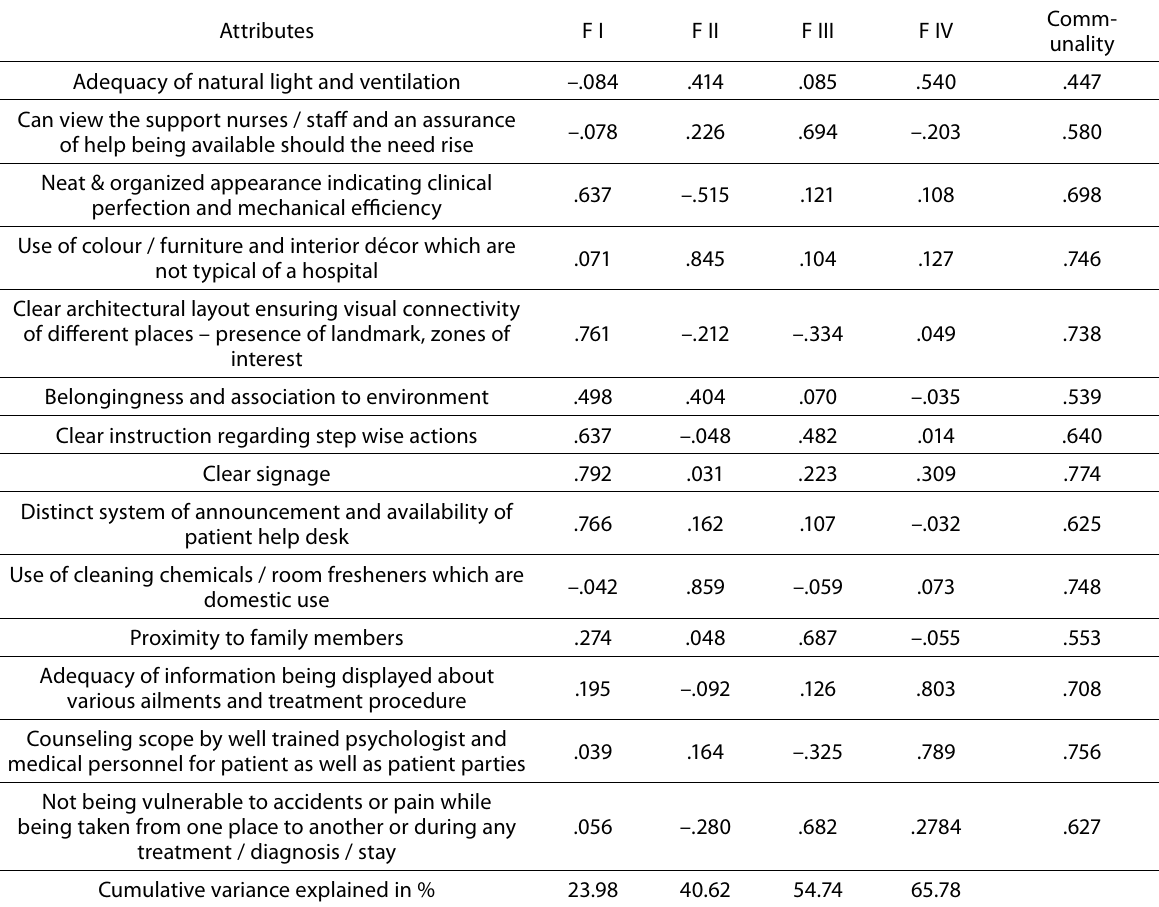
Table 4. Varimax rotation of principal factor